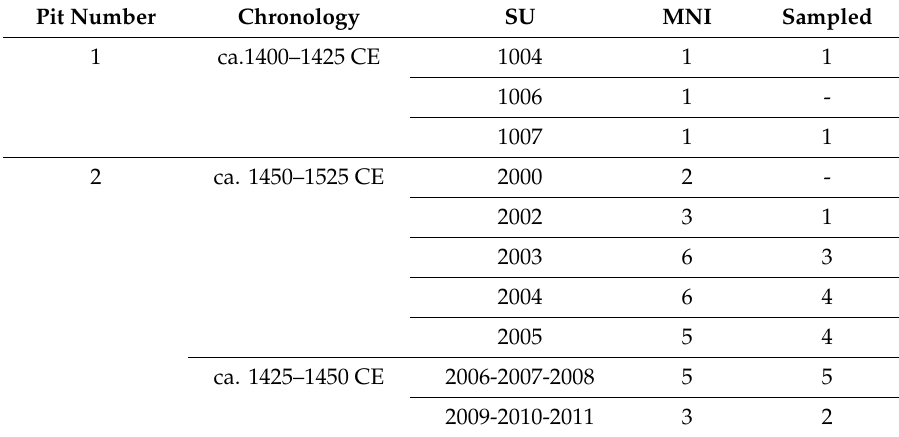
Table 1. Minimum Number of Individuals (MNI) of S. scrofa in each Stratigraphic Units (SU) of the two pits, and number of individuals sampled for aDNA